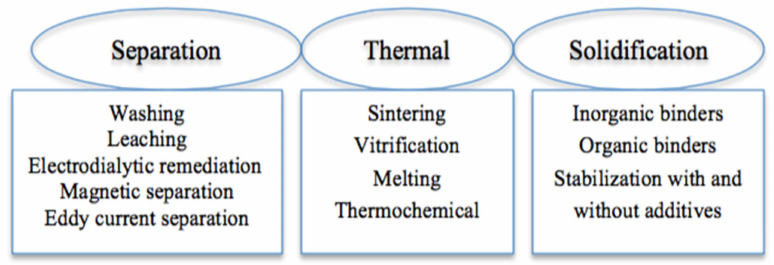
Figure 2. Shows the treatment techniques of incineration